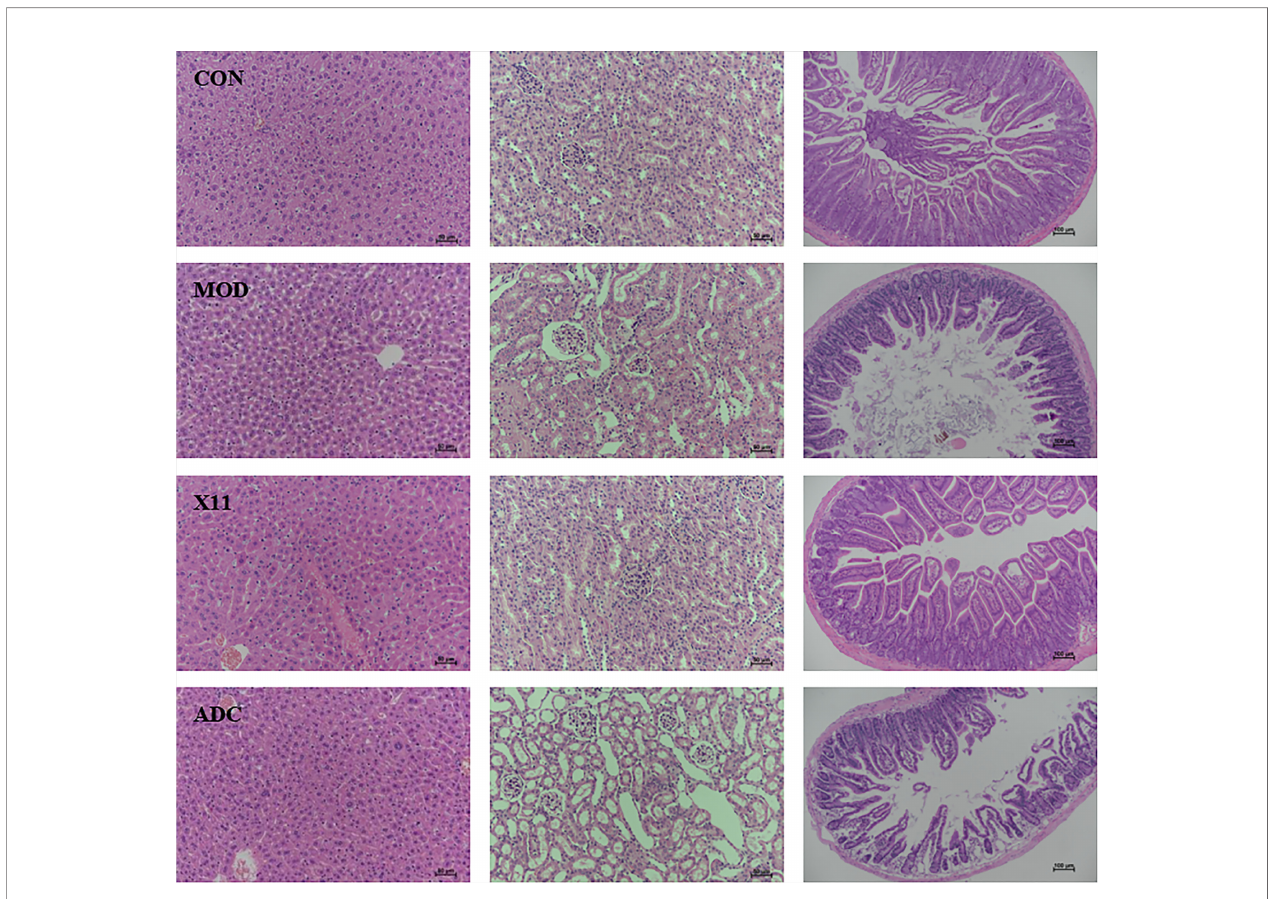
FIGURE 2 | Histopathological analyses of H&E-stained liver and kidney sections (×200 magni fi cation) and intense sections (×100 magni fi cation) from